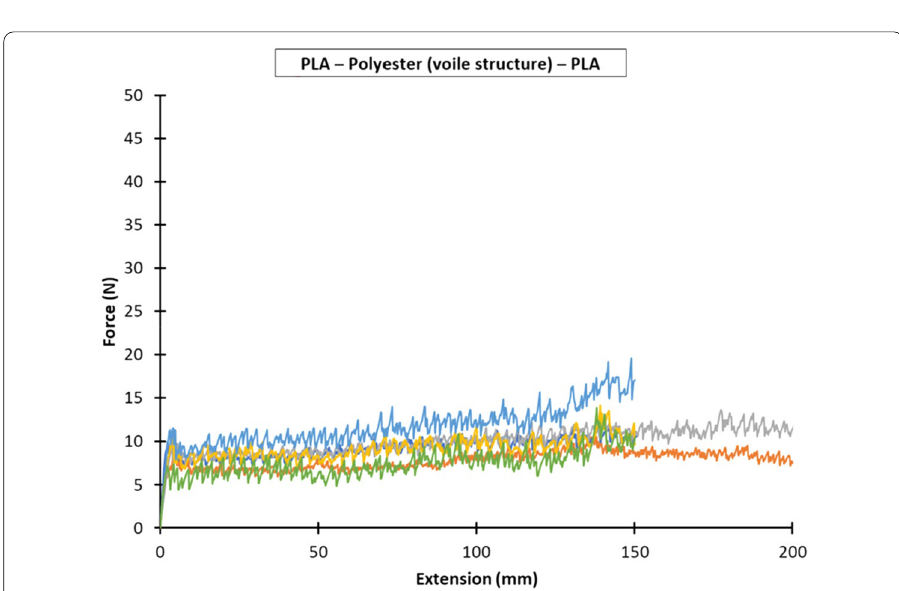
Fig. 8 Force versus extension plots for six specimens with the PLA—Polyester (voile structure)—PLA